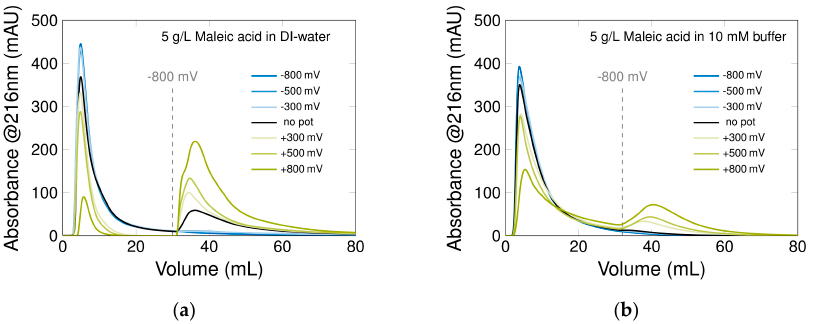
Figure 6. Potential-step experiments to determine the retention of maleic acid in ( a ) DI-water and ( b ) 10 mM phosphate buffer (pH ≈ 7, 50 μ L, 1 mL/min, 216 nm). The experiment was executed with different potentials applied during the adsorption phase (see legend); the elution was repeated each time with a potential switch to − 800 mV (horizontal line): ( a ) injection of 5 g / L maleic acid in DI-water; ( b ) injection of 5 g/L maleic acid in 10 mM phosphate buffer. The experiment was performed in column B with a potential switch at 30 mL.